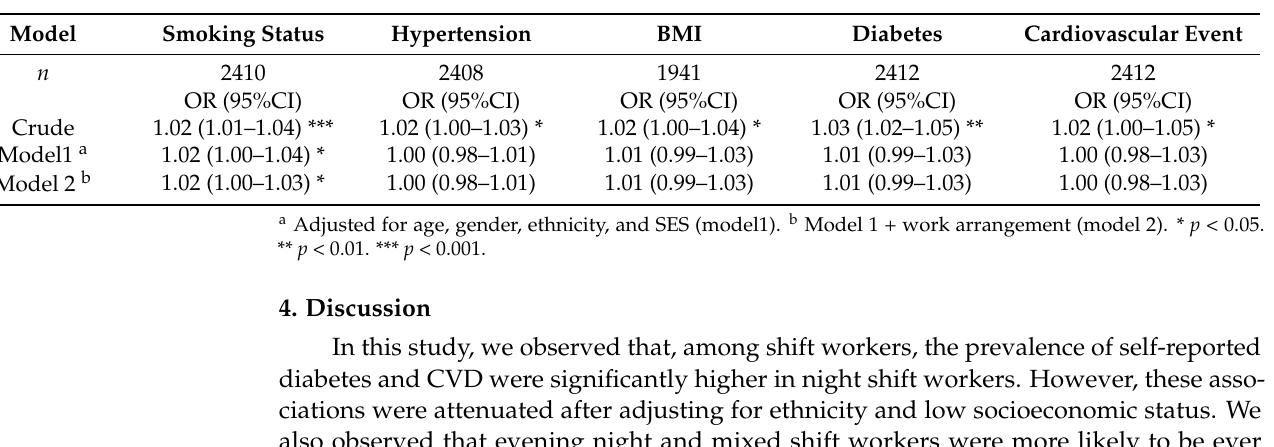
Table 4. Binary logistic regression of associations between shift duration (years) and CMD risk factors and disease